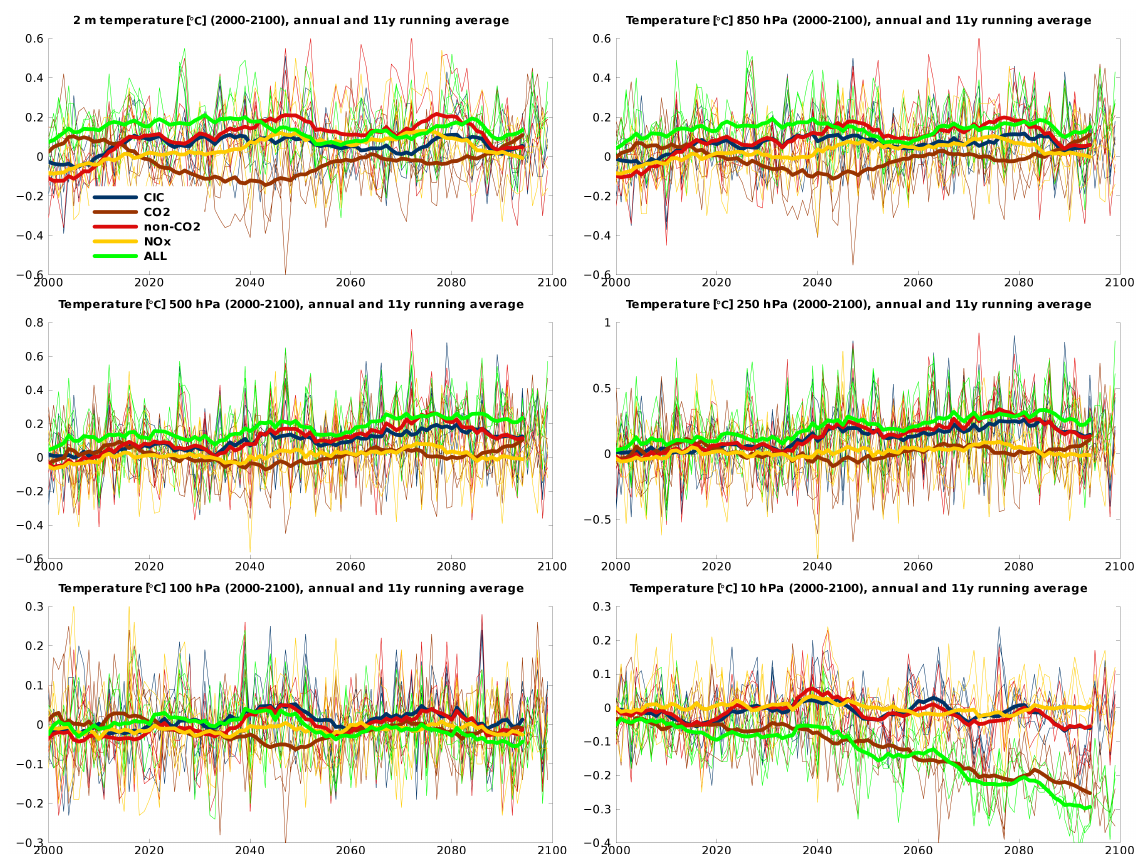
Fig. 9. Time series of the impact of aviation emissions on global temperature between 2000 and 2100 at six different pressure levels. Thin lines indicate the annual impact from each of the three members of a simulation, and the thick lines indicate the 11-yr running average of the ensemble mean. The blue, brown, red, yellow and green lines correspond to the CIC, CO 2 , non-CO 2 and NO x impacts, and the Total aviation impact,